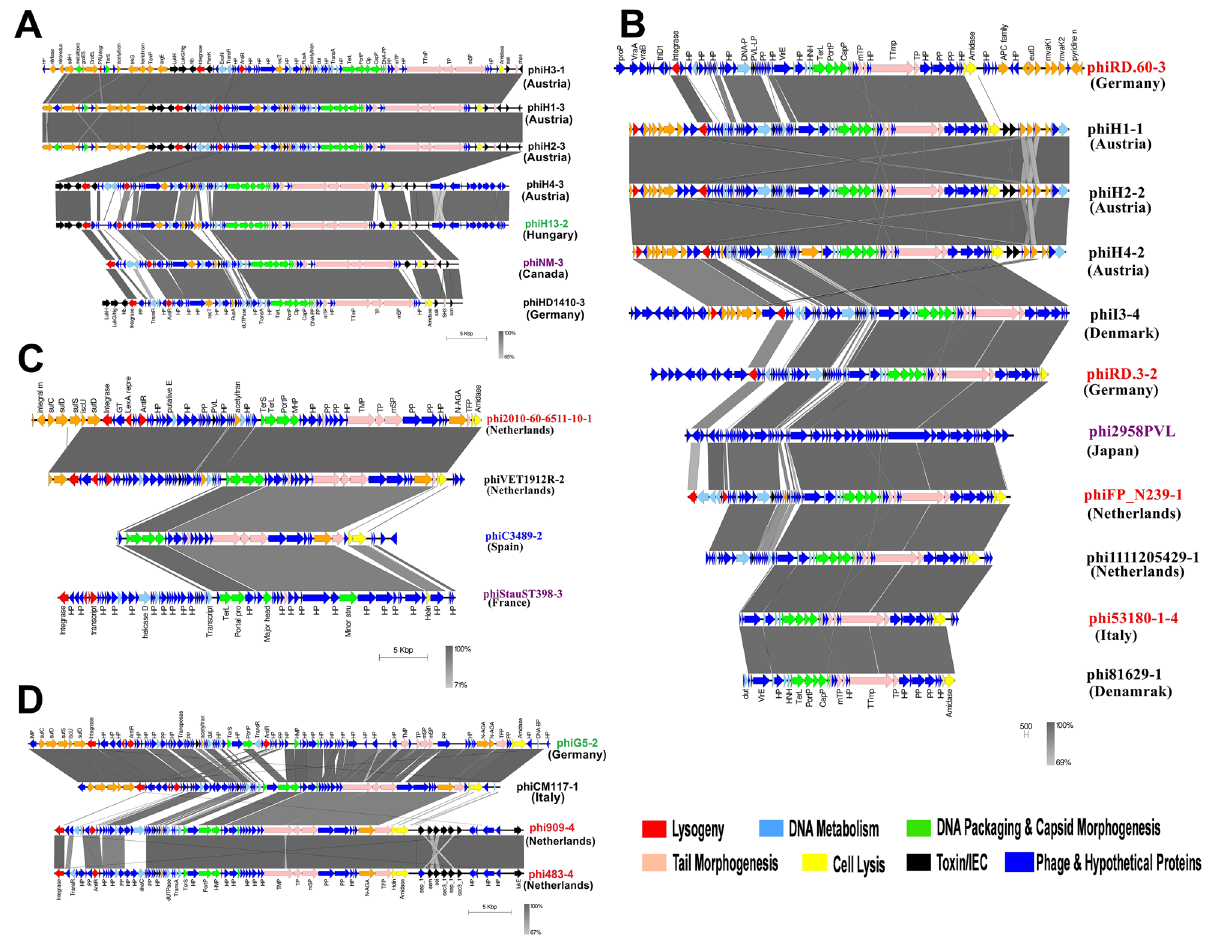
Figure 4. The mosaic architecture of S. aureus prophage genomes. ( A ) Comparison of prophages of clade 5, representing the prophages of subclade 5A, and phiH13-2 sequenced of our previous study 27 reported from Austria, Hungary, Canada (reference prophage), and Germany; ( B ) Comparison of prophages of clade 6, representing prophages of Homo sapiens and Bos tourus - associated S. aureus spreading in Germany, Austria, Denmark, Netherlands, Japan (reference prophage), and Italy; ( C ) Comparison of prophages of clade 7, representing subclade 7A prophages Homo sapiens , Bos tourus, and Canis lupus familiaris -associated S. aureus reported from Netherland, Spain, and France; ( D ) Comparison of prophages of clade 7, representing phiG5-2 prophage sequence of our previous study 25 and 3 prophages of subclade 7B associated with S. aureus reported from Italy, and Netherland. Phages and country of origins are indicated on the right (the prophage names labeled in black, red, blue, and purple color indicate prophages associated with Homo sapiens , Bos tourus, Canis lupus familiaris, and reference, respectively. And prophage names labeled in green color indicated the prophages extracted from our previous study 25,27 and grey shaded regions are homologous